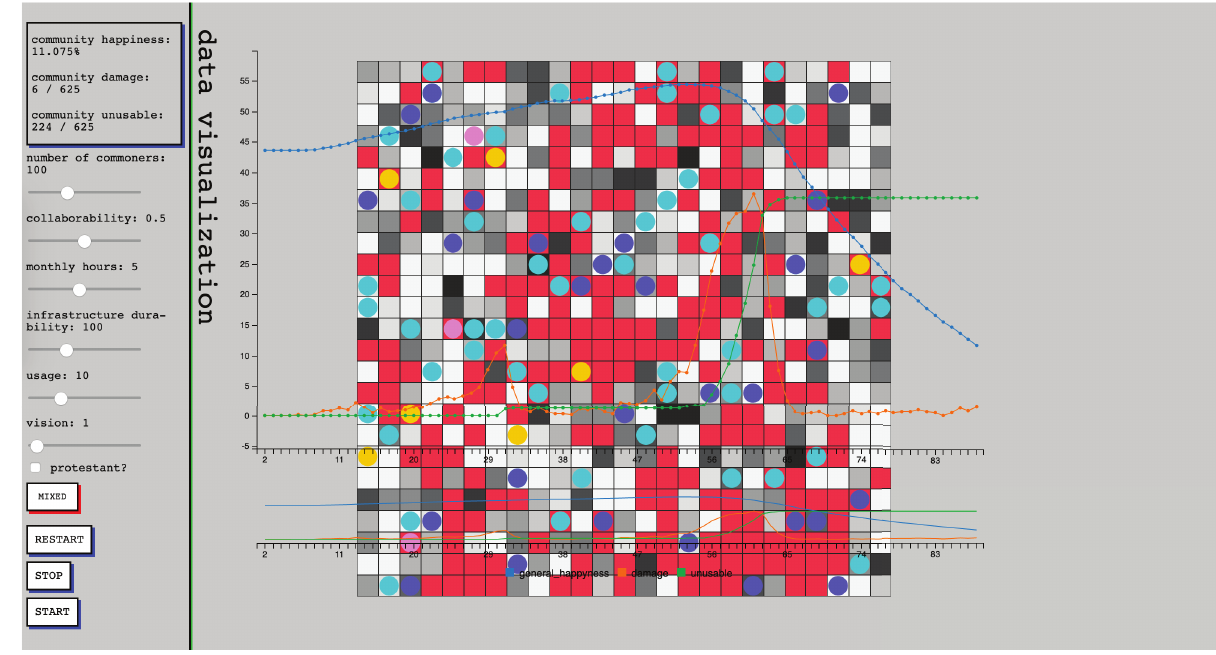
Figure 1: Screeshot of 2nd